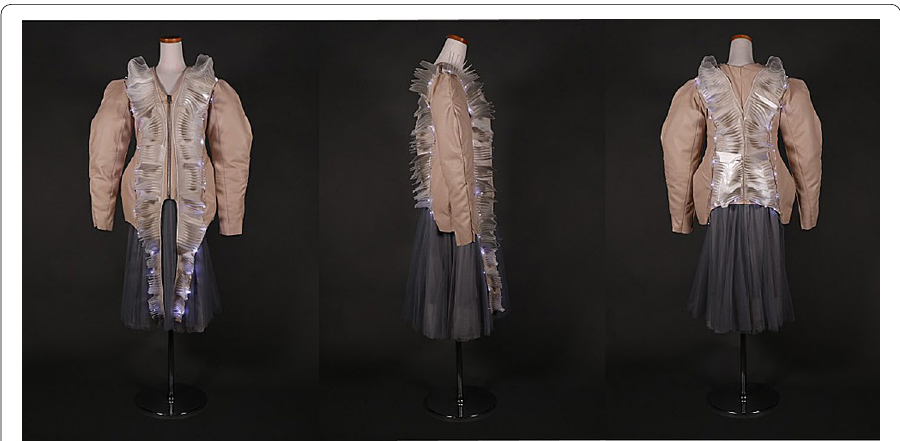
Fig. 4 Final product of ‘Design